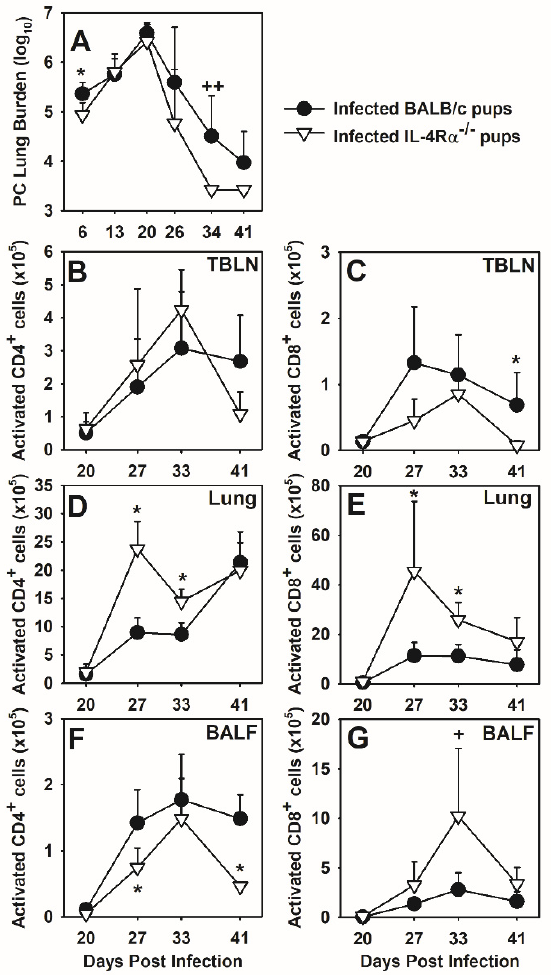
Figure 6. T cells are differentially activated in IL-4R α − / − neonates infected with P. murina . Two-day old BALB/c and IL-4R α − / − neonates were infected with 5 × 10 5 P. murina organisms/g body weight. At indicated days post infection, TBLN, lungs, and BALF were collected from 4–7 mice per group. ( A ) P. murina lung burden was determined microscopically. Cells from TBLN ( B , C ), lung digest ( D , E ), and BALF ( F , G ) were stained with antibody against CD4, CD8, CD44 and CD62L and analyzed by flow cytometry. T cell subsets expressing high CD44 and low CD62L were considered to be activated. Data represent the means ± SD and are representative of 2 independent experiments. * p ≤ 0.05; +, p = 0.067 comparing P. murina infected BALB/c neonates to P. murina infected IL-4R α − / − neonates. ++, organisms burden was below limit of detection for 4 of 4 mice in the IL-4R − / − group and 1 of 4 mice in the BALB/c mice at day 35 and 4 of 4 and 2 of 4 for the IL-4R − / − and BALB/c mice, respectively, at day 41.